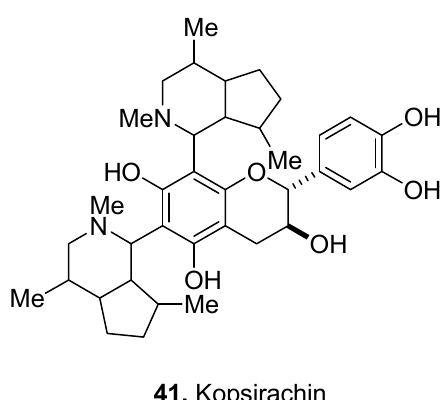
Figure 15. Kopsirachin ( 41 ).